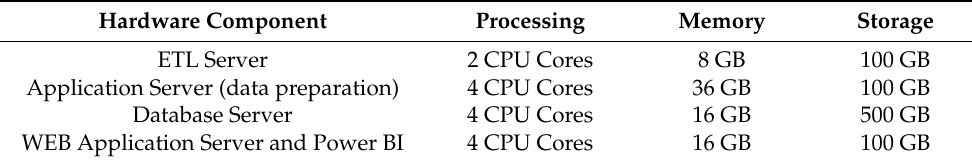
Table 10. Hardware